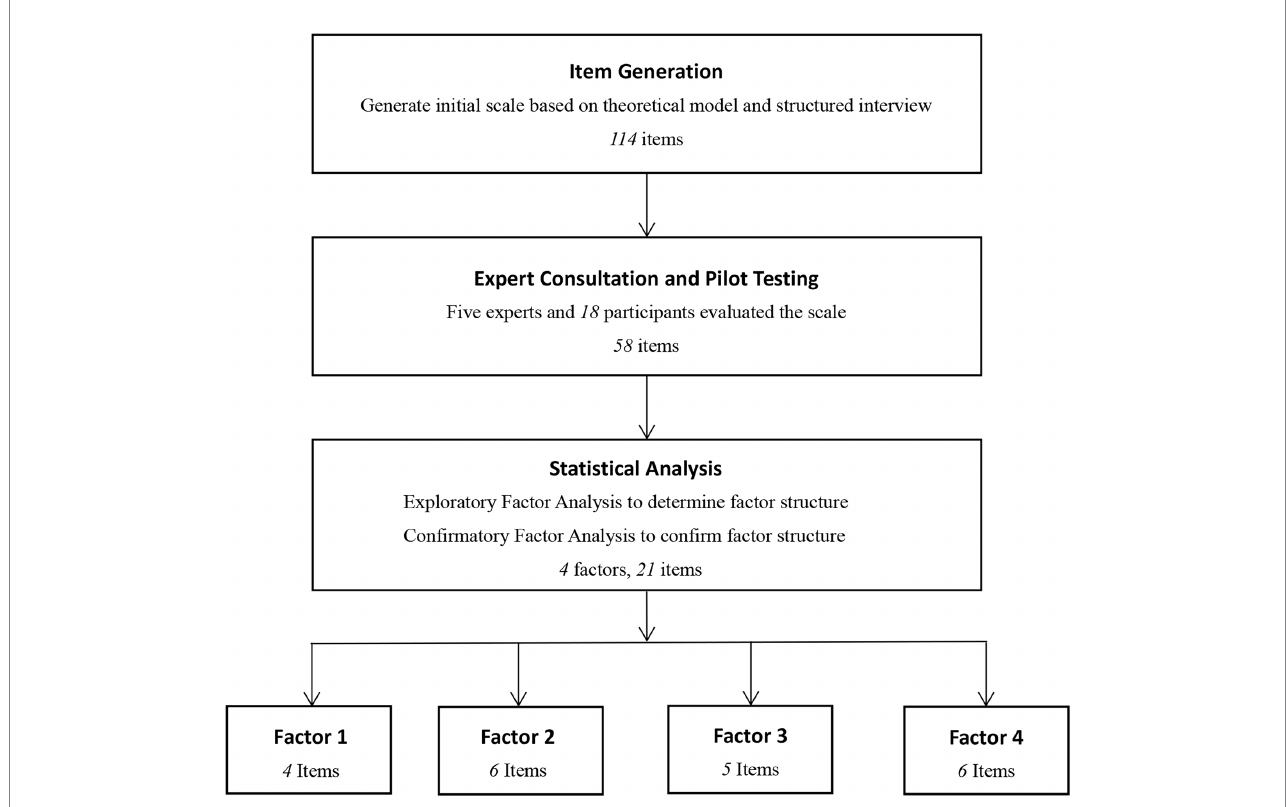
FIGURE 2 The development of social anxiety cognition scale for college